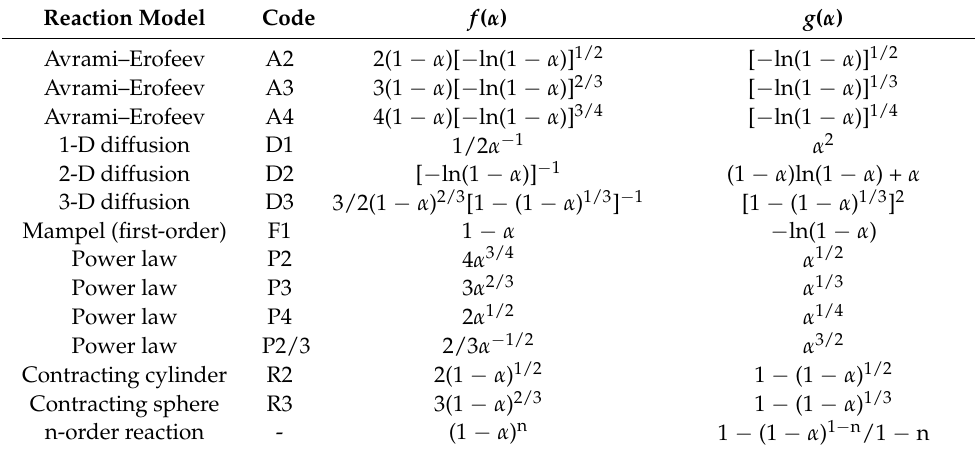
Table 3. Kinetic reactions models f ( α ) and g ( α )